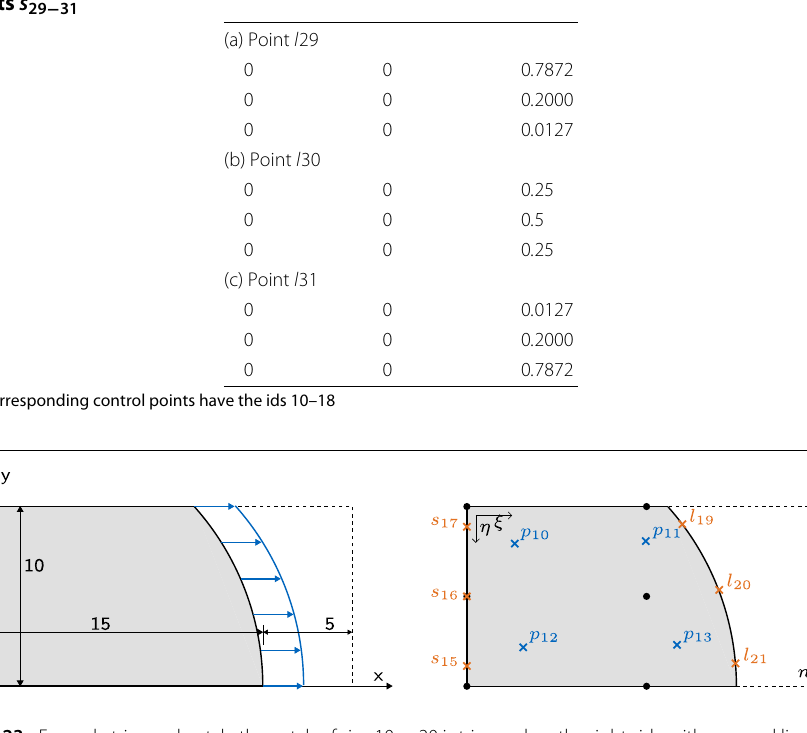
Fig. 23 Example trimmed patch: the patch of size 10 × 20 is trimmed on the right side with a curved line. The quadratic patch has 9 control points and is integrated with 4 quadrature points. On the trimmed edge a Neumann boundary condition of f = 1/unit is applied